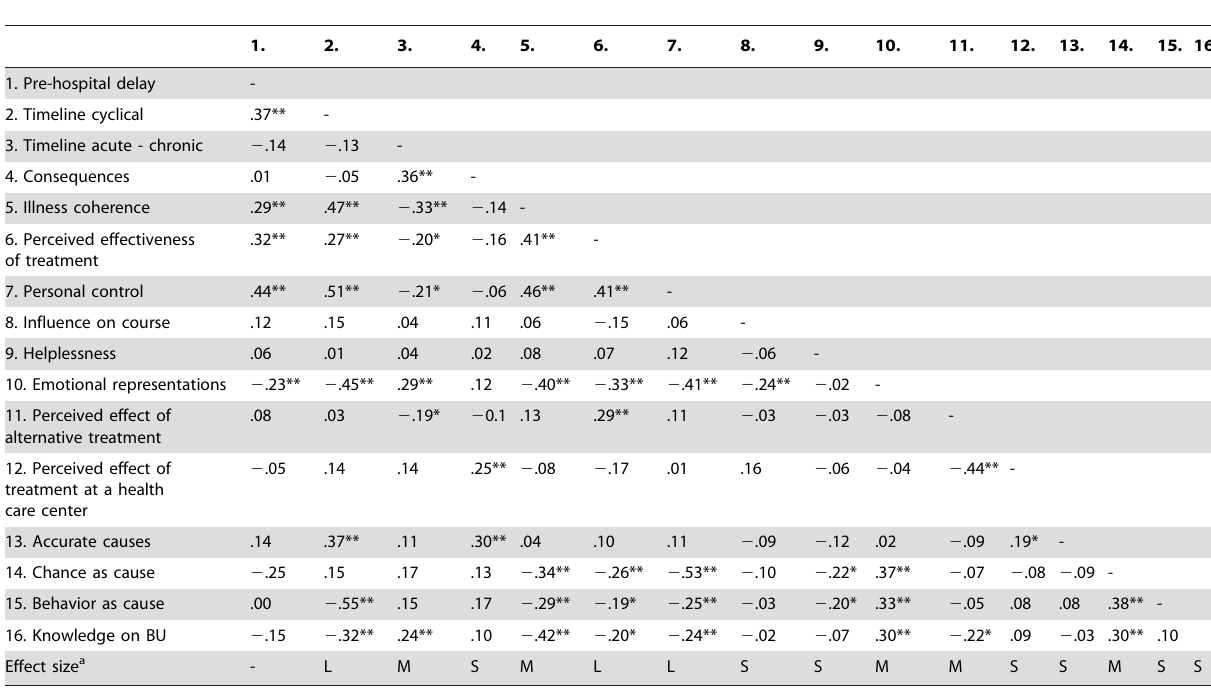
Table 2. Inter-correlations between explanatory variables, and pre-hospital delay.